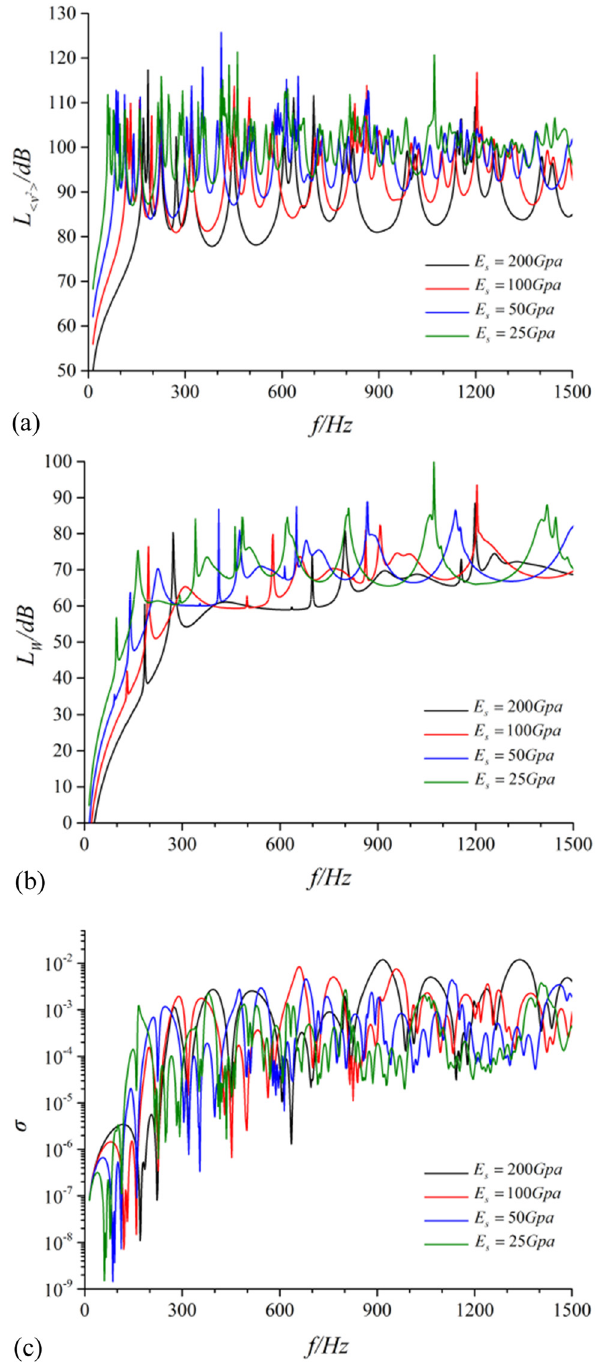
Figure 3: Contrast of vibration and noise performance for the cylindrical shell under di ff erent elasticity moduli. ( a ) Radial quadratic velocity level, ( b ) sound radiation power level, and ( c ) sound radiation e ffi